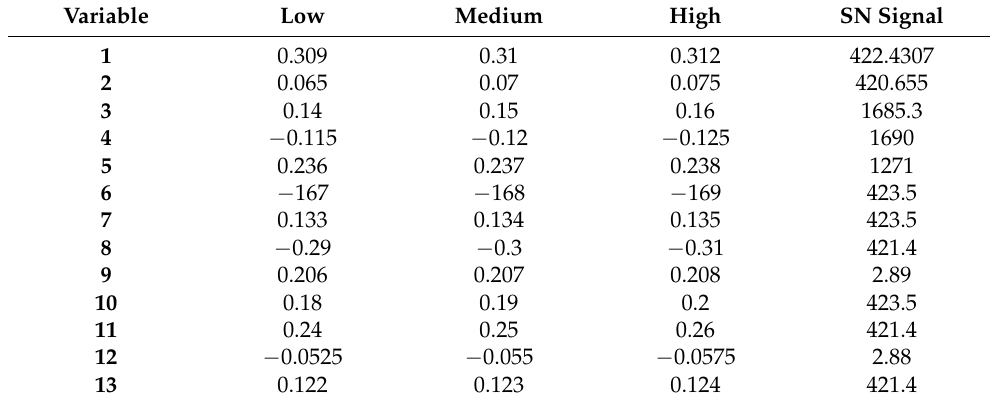
Table 4. Tested variables and their